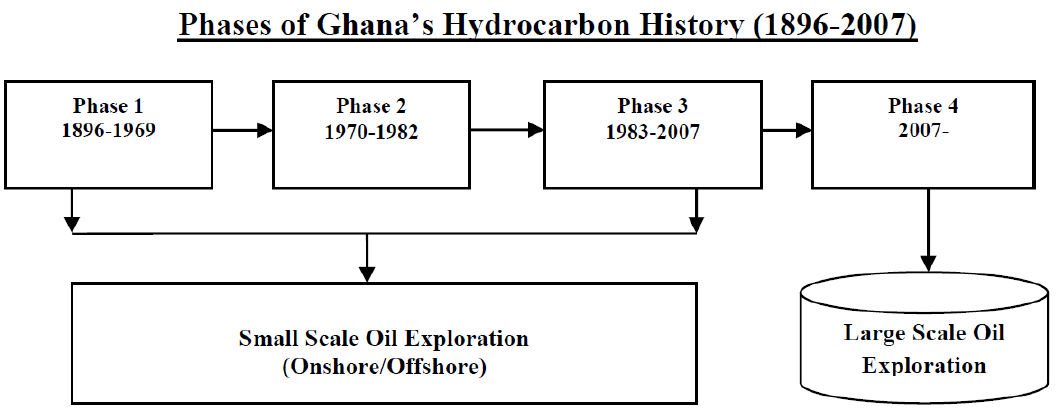
Figure 1. Phases of Ghana’s Hydrocarbon History. Source: Model designed by the author with ideas from Jones [19] and Kumah-Abiwu [20].